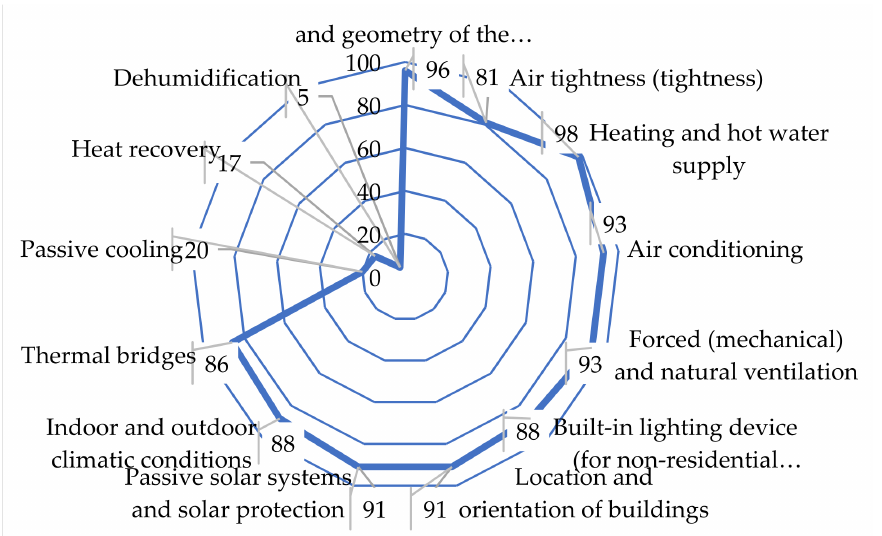
Figure 2. Consideration of energy efficiency conditions when assessing the energy efficiency of buildings (constructed by the authors based on the “Comparative Review of Energy Efficiency Standards and Technologies for Buildings in the UNECE Region for 2018”